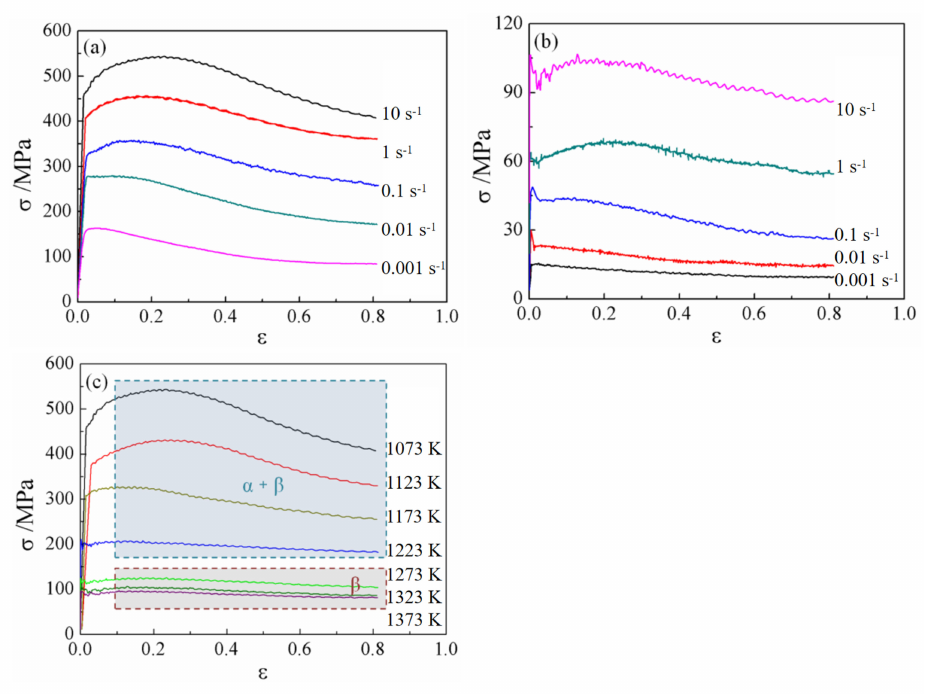
Figure 2. True stress-strain curves of Ti-6.5Al-3.5Mo-1.5Zr-0.3Si titanium ally with various strain rates and deformation temperatures: ( a ) 1073 K, ( b ) 1323 K, and ( c ) 10 s − 1 . The softening stresses ( ∆ σ = σ p − σ ss ) at different deformation temperatures and strain rates, which indicate the index of dynamic softening effect, are presented in the form of a three-dimensional image, as shown in Figure 3. Apparently, the softening stress increases significantly with the decreasing of temperature or the increasing of strain rate. While at a low strain rate, the softening stress is kept almost constant during different deformation temperatures. In other words, the value of softening stress is sensitive to deformation temperature and strain rate. For titanium alloys, deformation heat and microstructure changes are major factors to cause flow softening